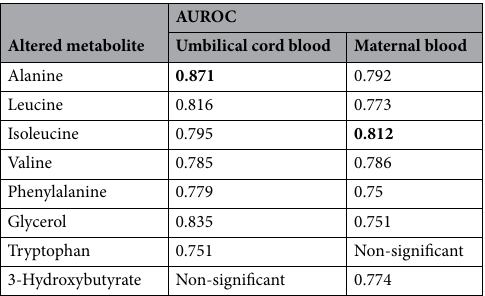
Table 1. Comparison of AUROCs for discriminatory metabolites among umbilical cord blood and maternal samples. Values in bold refer to metabolites presenting the higher AUROC.